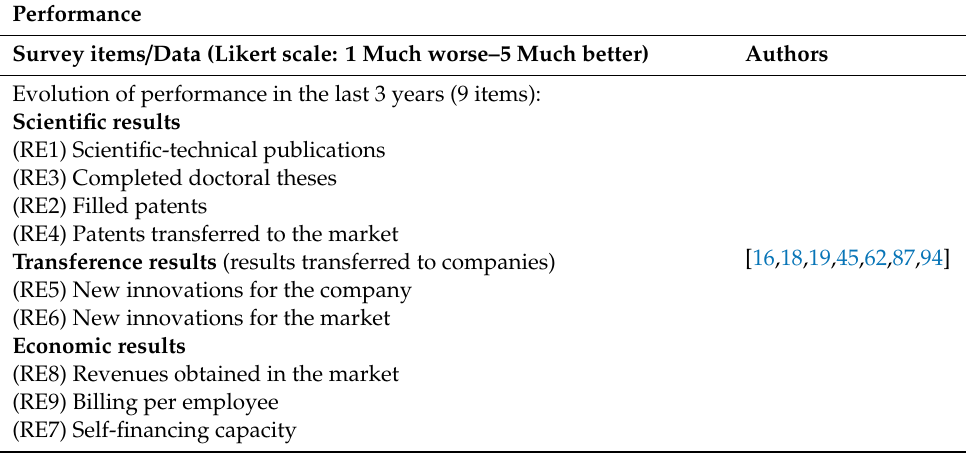
Table 4. Performance survey